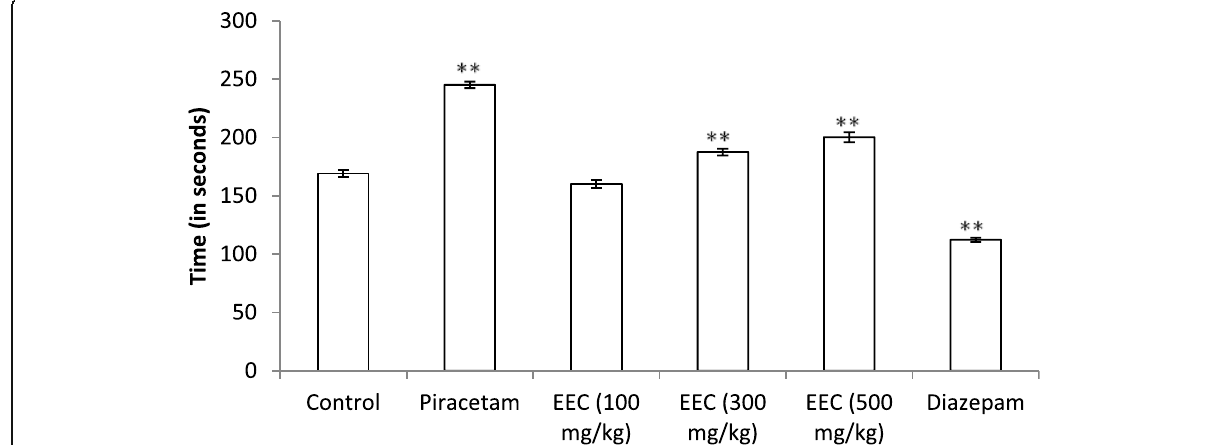
Fig. 2 Effect of EEC on step down latency (SDL) using passive avoidance paradigm.All values are mean ± SEM (n = number of animals in each